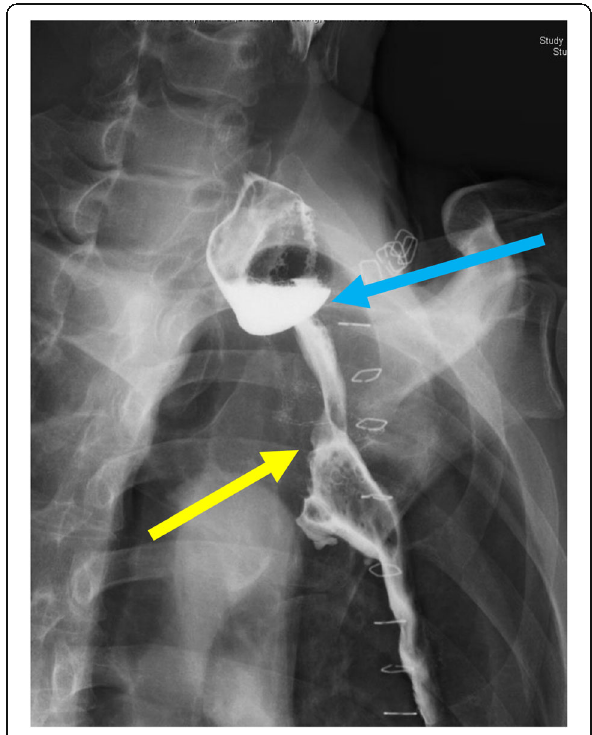
Fig. 5 Image showing upper gastrointestinal fluoroscopy taken 8 days after the operation. The passage through both the esophagogastric tube anastomosis (blue arrow) and the gastric tube jejunal anastomosis (yellow allow) is